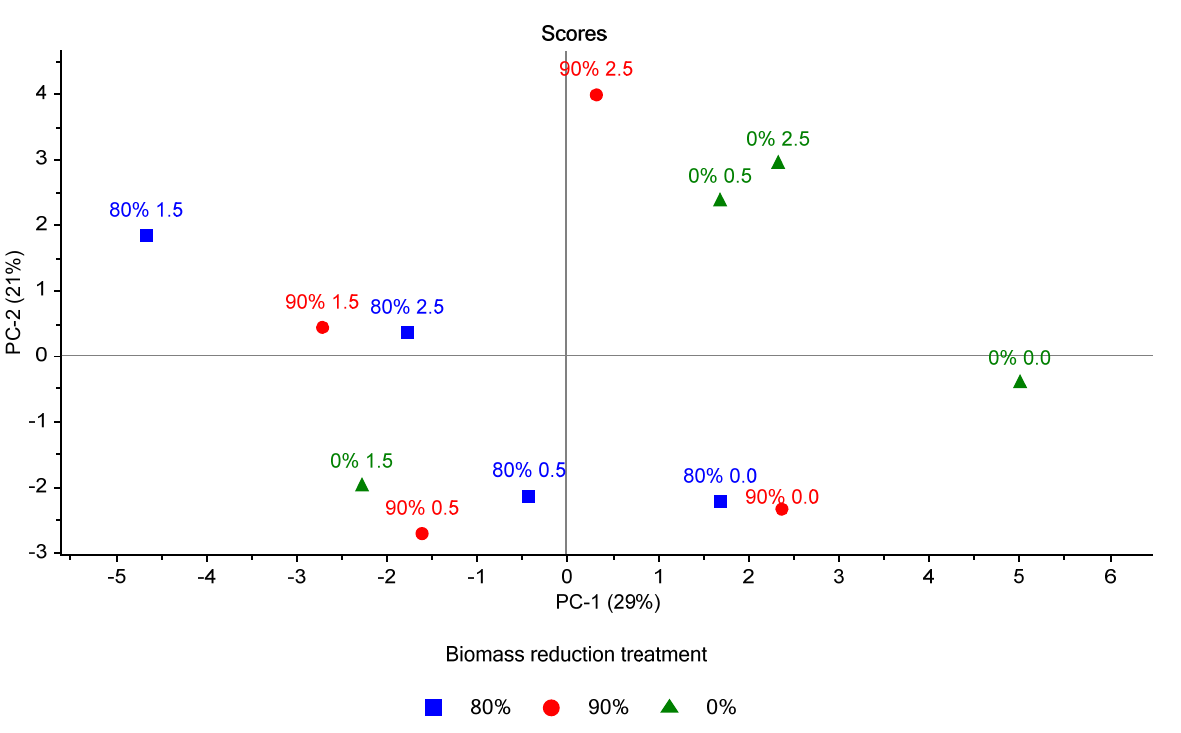
Figure 8. Scores plot showing the results of the principal component analysis performed on the normalised volatile data. The label of each point gives the biomass reduction treatment (with % symbol), followed by the L-phe spike concentration (in g L − 1 ).